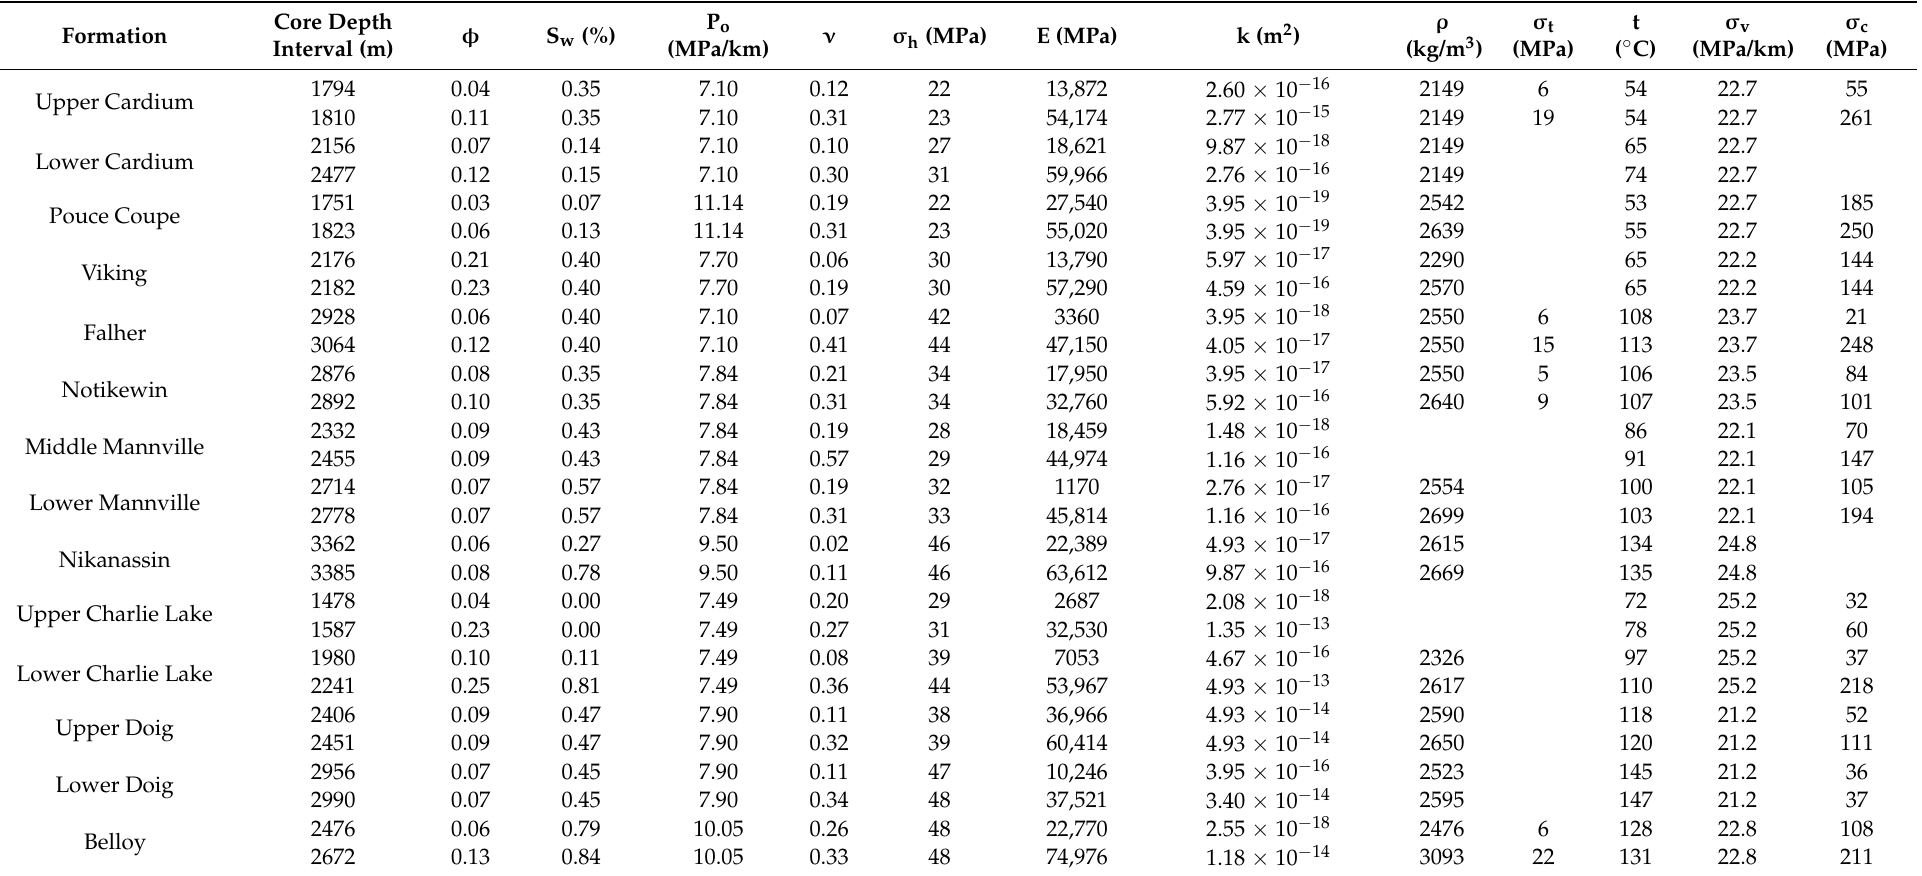
Table 2. Stratigraphic zones and minimum–maximum ranges of geological, geomechanical and petrophysical parameters used to construct geomechanical models for the Mesozoic Era formations of interest. Upper and lower numbers represent the minimum and maximum ranges of values for each parameter across the core sample depth